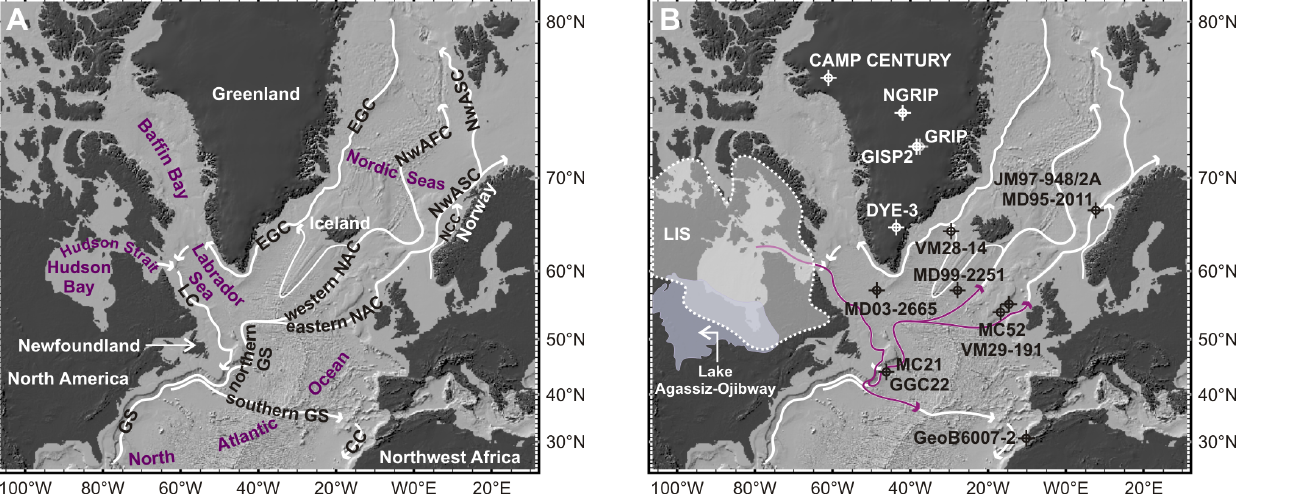
Figure 1a. The modern (sub)surface-current system in the north- ern North Atlantic Ocean and the Nordic Seas (Orvik and Niiler, 2002). CC: Canary Current. GS: Gulf Stream. NAC: North At- lantic Current (or North Atlantic Drift). The two branches of the Atlantic Inflow into the Nordic Seas or the Norwegian Atlantic Cur- rent (NwAC) are the Norwegian Atlantic Slope Current (NwASC) and the Norwegian Atlantic Front Current (NwAFC). NCC: Norwe- gian Coastal Current. EGC: East Greenland Current. LC: Labrador Current. The base map (identical in Fig. 1a–b) was generated by GeoMapApp © 3.3.0 (Ryan et al., 2009).